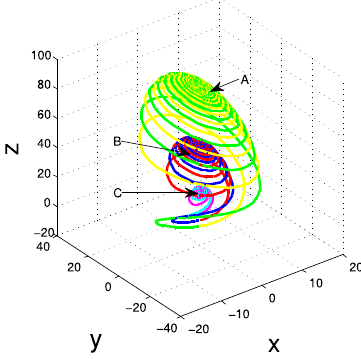
Figure 4. Singularly degenerate heteroclinic cycles of system (1.3) with (A) ( x 0 ,y 0 ,z 0 ) = ( ± 3 . 82 × 1 e − 5 , ± 6 . 18 × 1 e − 5 , − 7), (B) ( x 0 ,y 0 ,z 0 ) = ( ± 3 . 82 × 1 e − 5 , ± 6 . 18 × 1 e − 5 , − 3) and (C) ( x 0 ,y 0 ,z 0 ) = ( ± 3 . 82 × 1 e − 5 , ± 6 . 18 × 1 e − 5 , 1) when ( a,b,c ) = (3 , 4 , 0). These figures suggest that system (1.3) has infinitely many singularly degenerate heteroclinic